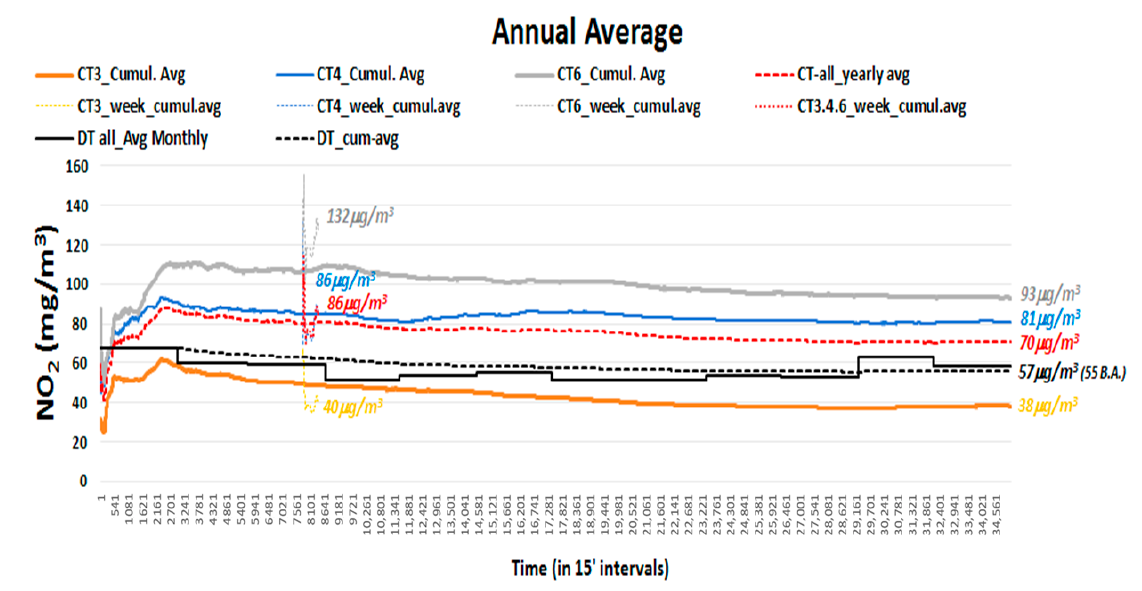
Figure 6. Cumulative average NO 2 Concentrations (µg/m 3 ) at CoL CMS and Diffusion Tube Sites (2017 Calendar Year and Survey Period (Excluding times when the Smogmobile was not operating, e.g., overnight stays in car parks and during lunch breaks.).